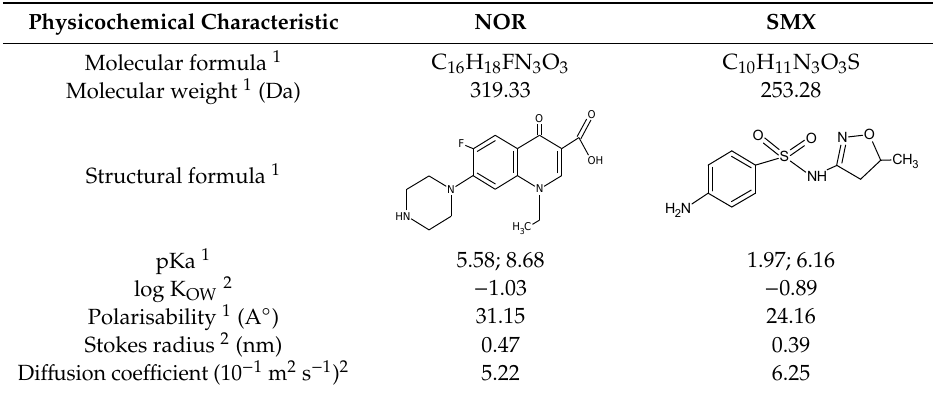
Table 1. Physicochemical characteristics of norfloxacin (NOR) and sulfamethoxazole (SMX).